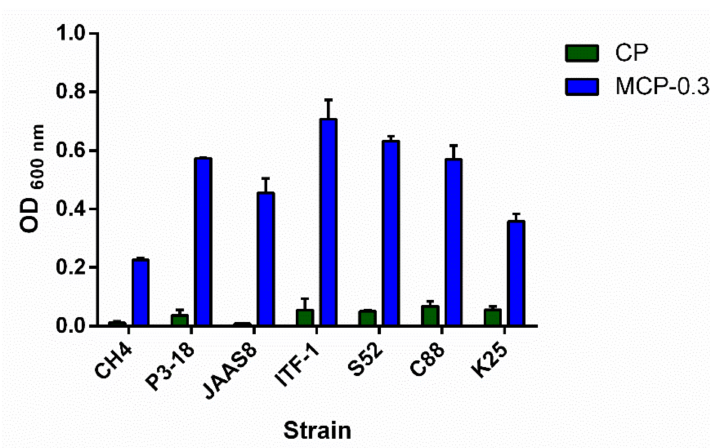
Figure 9. E ff ects of CP and MCP-0.3 on the growth of L. plantarum strains CH4, P3-18, S52, C88, K25, and L. rhamnosus CG strains JAAS8 and